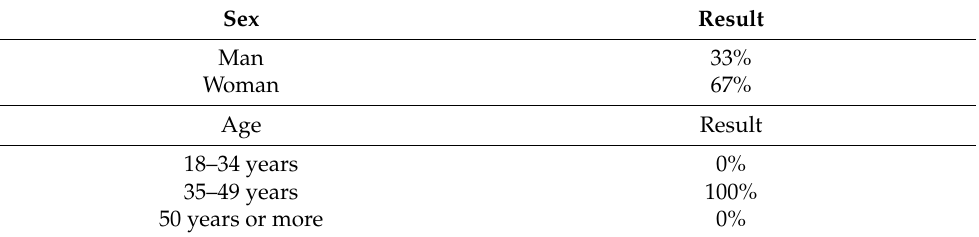
Table 1. Sex and age of the hotel managers interviewed.